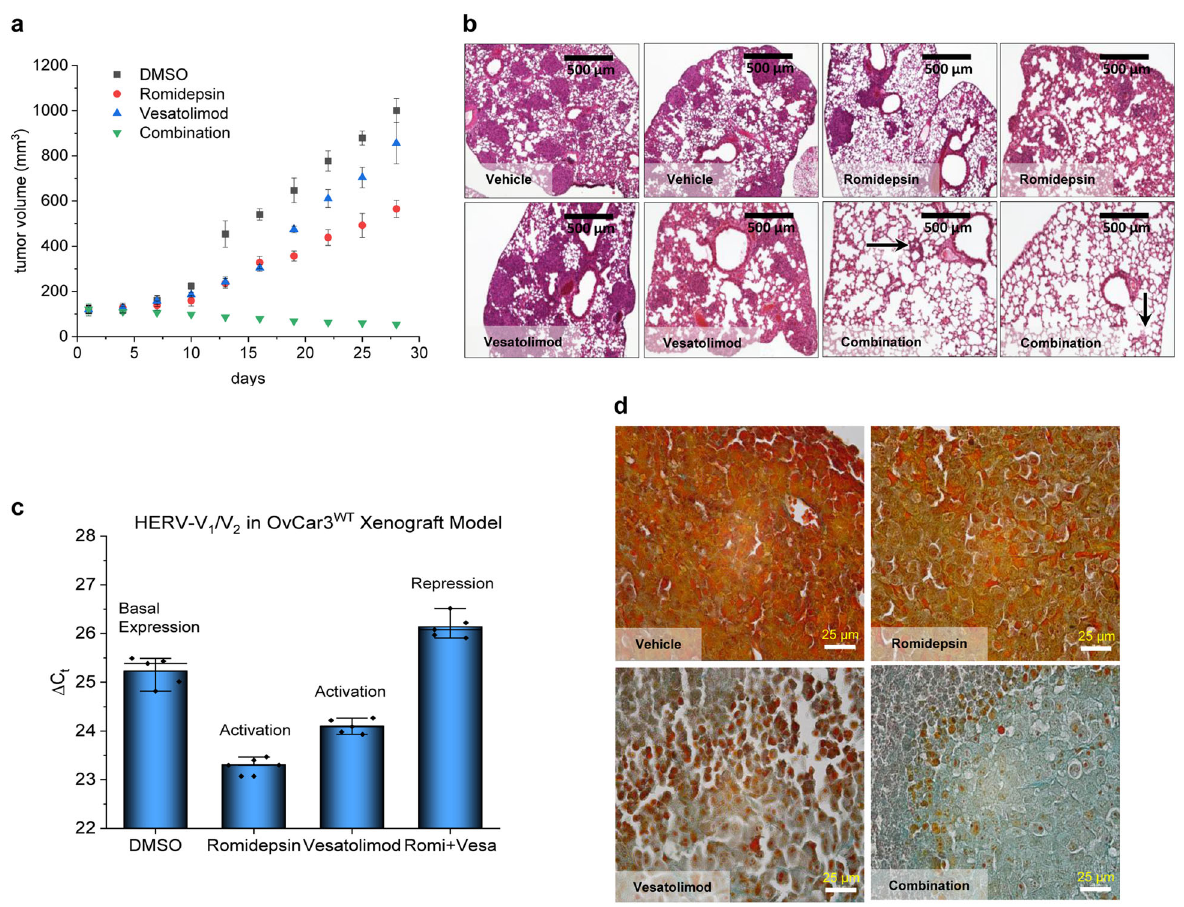
Fig. 8 Ovarian carcinoma xenograft model in NMRI nu/nu mice. a Tumour-bearing female NMRI nude mice were intraperitoneally treated four times at 4-day intervals with romidepsin or vesatolimod at a dose of 1 mg/kg and 5 mg/kg body weight, respectively, and with the corresponding drug combinations. Tumour volumes were calculated and plotted. Both romidepsin and vesatolimod alone show a mild antitumoral activity, as determined by the tumour size. However, when combined, their antitumoral activity is clearly enhanced. b In the dissemination model, mice were treated as described above after 3 days of cell inoculation, and the lungs were examined by HE staining. Under HTCT, colonisation of the lungs was signi fi cantly reduced in comparison to the single-drug treatments. c OvCar3 WT xenograft model treated with subtherapeutic doses (0.5 and 2.5 mg/kg of romidepsin and vesatolimod, respectively); the remnant tumours were examined for HERV-V1/V2 expression by qPCR and returned similar results to the in vitro studies. d IHC of DAB staining for HERV-V1/V2 in OvCar3 WT remnant tumours. A reduction in the expression of these retroviral proteins is observed. The graphs are representative of n = 3